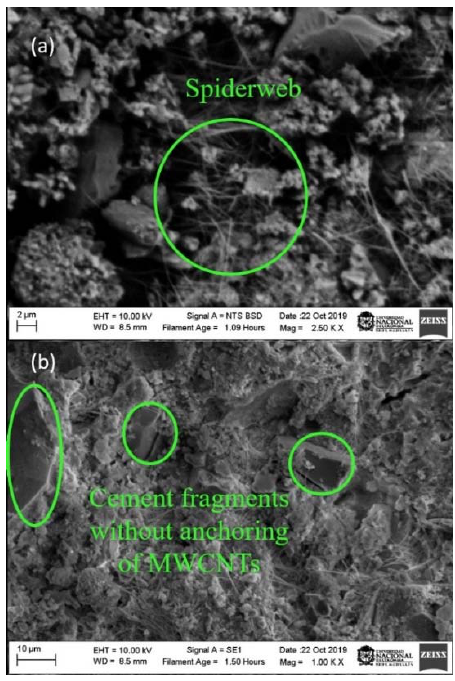
Figure 8. Scanning electron microscope (SEM) images of Portland cement specimens with a dispersion solution addition at 190 J/g. ( a ) 2 μ m ( b ) 10 μ m.